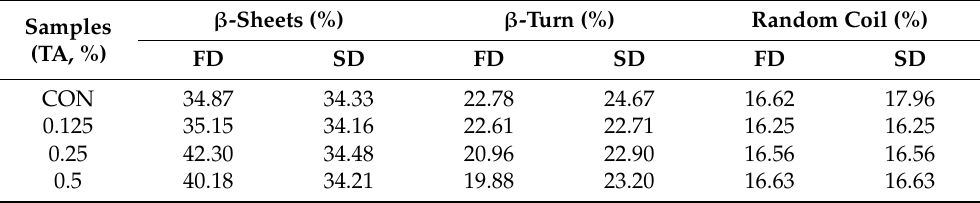
Table 2. Secondary structure of freeze-dried (FD) and spray-dried (SD) fish myofibrillar proteins (FMP) modified with tannic acid (TA) at varying